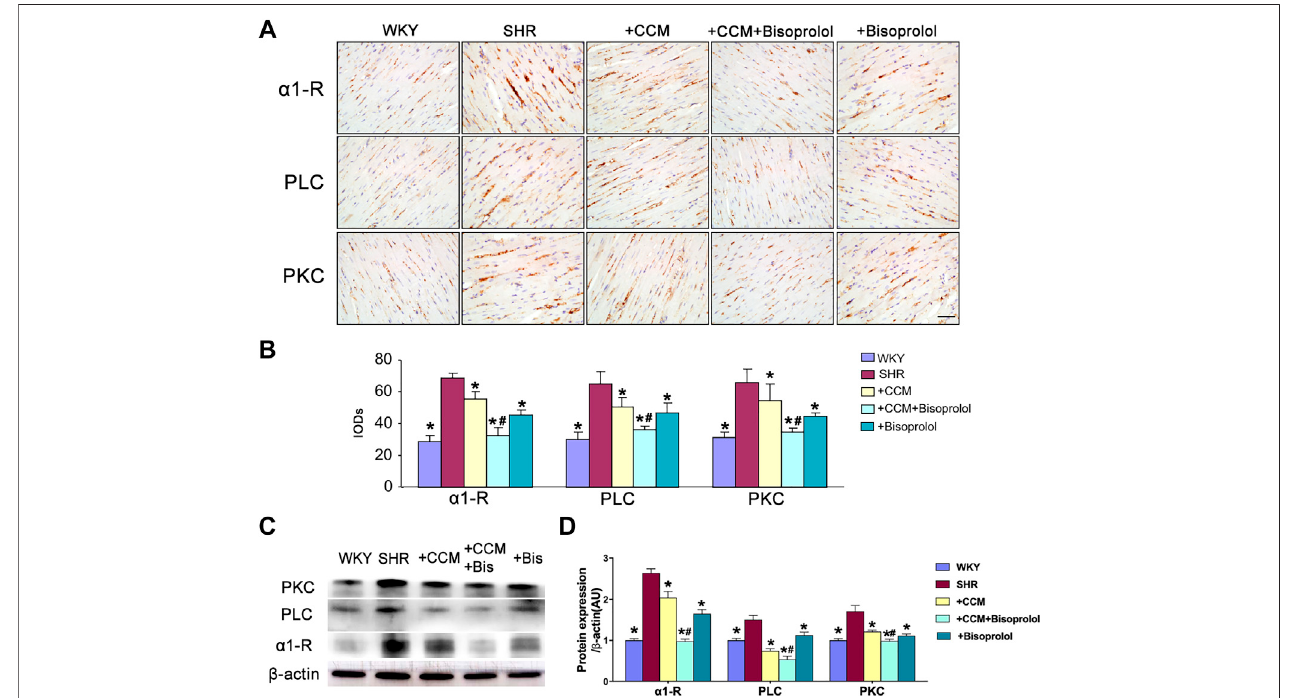
FIGURE 6 | CCM therapy reduces the α 1/PLC/PKC signaling in SHRs hearts. Male SHRs at the age of 8 – 12 weeks old fed with normal diet received bisoprolol administration (5 mg/kg/day) or plus CCM therapy for 10 weeks. (A,B) Immunohistochemistry and quantitative analysis of α 1/PLC/PKC signaling in hearts. scale bar: 200 μ m. (C,D) Western blot and quantitative analysis of α 1/PLC/PKC signaling in hearts. Quantitative results are expressed as mean ± SEM. N is 10 – 15 in each group. * p < 0.05 vs. SHRs. # p < 0.05 vs. SHRs plus